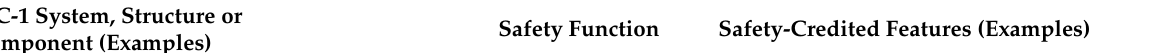
Table 2. List of safety-credited systems or components and design features (safety function in second column can be consulted in ref.